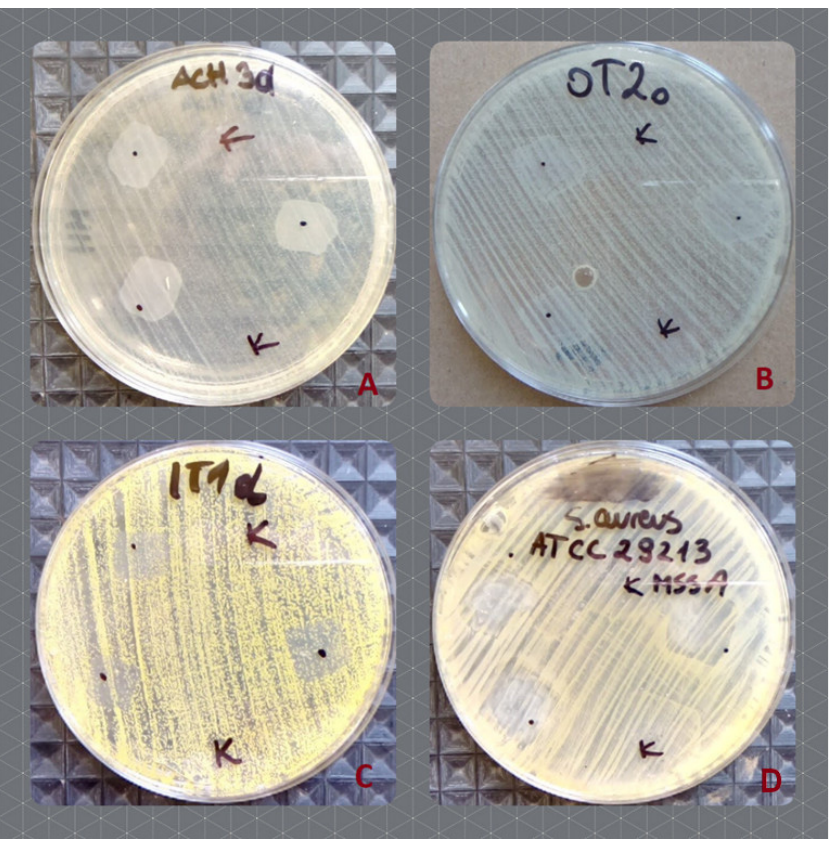
Figure 6. The effect of the Hyal/O 3 (dots) and control Hyal (K) foils on the growth of the selected bacterial strains. ( A )—increased growth of S. epidermidis, isolated from the hands; ( B )—increased growth of S. epidermidis, isolated from the under eye region; ( C )—inhibited growth of M . luteus, isolated from hands, ( D )—inhibited growth of the type strain of methicillin susceptible S. aureus ATCC 29213. Table 4. Growth inhibition zones for the bacterial and Candida strains, as a result of the Hyal/O 3 foil application